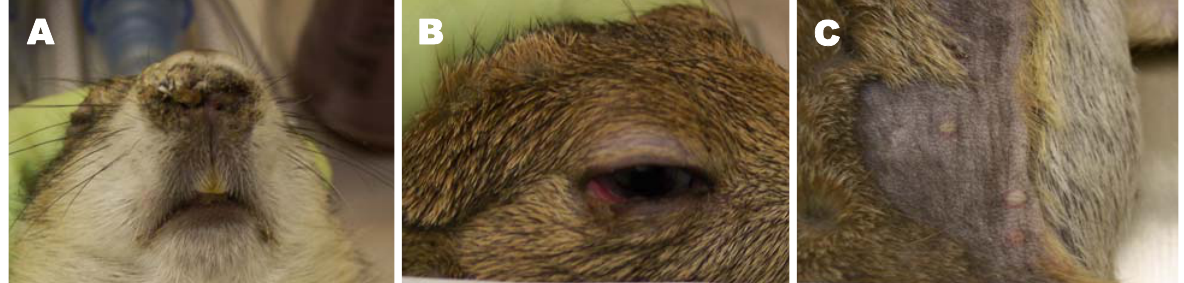
Figure 2. Clinical signs of monkeypox in experimentally prairie dogs. ( A ) Nasal discharge; ( B ) Blepharitis and ( C ) Disseminated skin lesions (Photos associated with the study available at